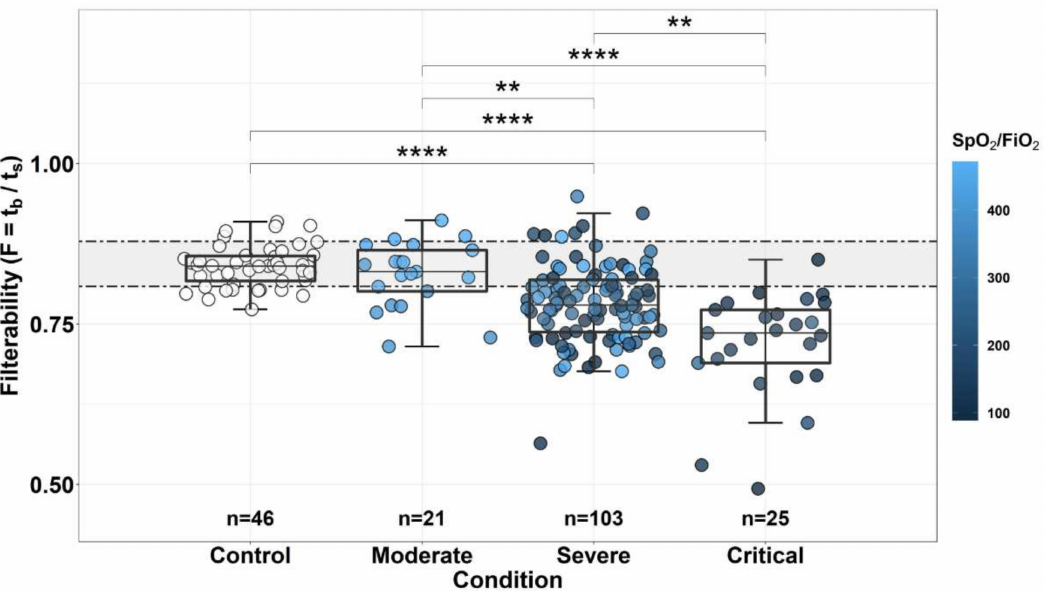
Figure 1. Dependence of erythrocyte filterability on the severity of the patient’s condition. Control— control group, Moderate—a condition of moderate severity, Severe—a serious condition, Critical—a condition of extreme severity. In addition, each represented point is automatically colored according to the SpO 2 /FiO 2 ratio for given measurement (see the color scale to the right of the figure). The significance of the differences between the groups was calculated using the Kruskal–Wallis H-test and post-hoc Dunn’s test with Bonferroni correction. Horizontal dotted lines show the boundaries of normal filterability values. The box sizes correspond to the range comprising from 25 to 75 percentiles of all measured values. Medians are indicated by horizontal lines, and the length of the whiskers corresponds to the 1.5 interquartile range. The p values for the significance of the differences are shown in the figure: ** p < 0.01 and **** p <